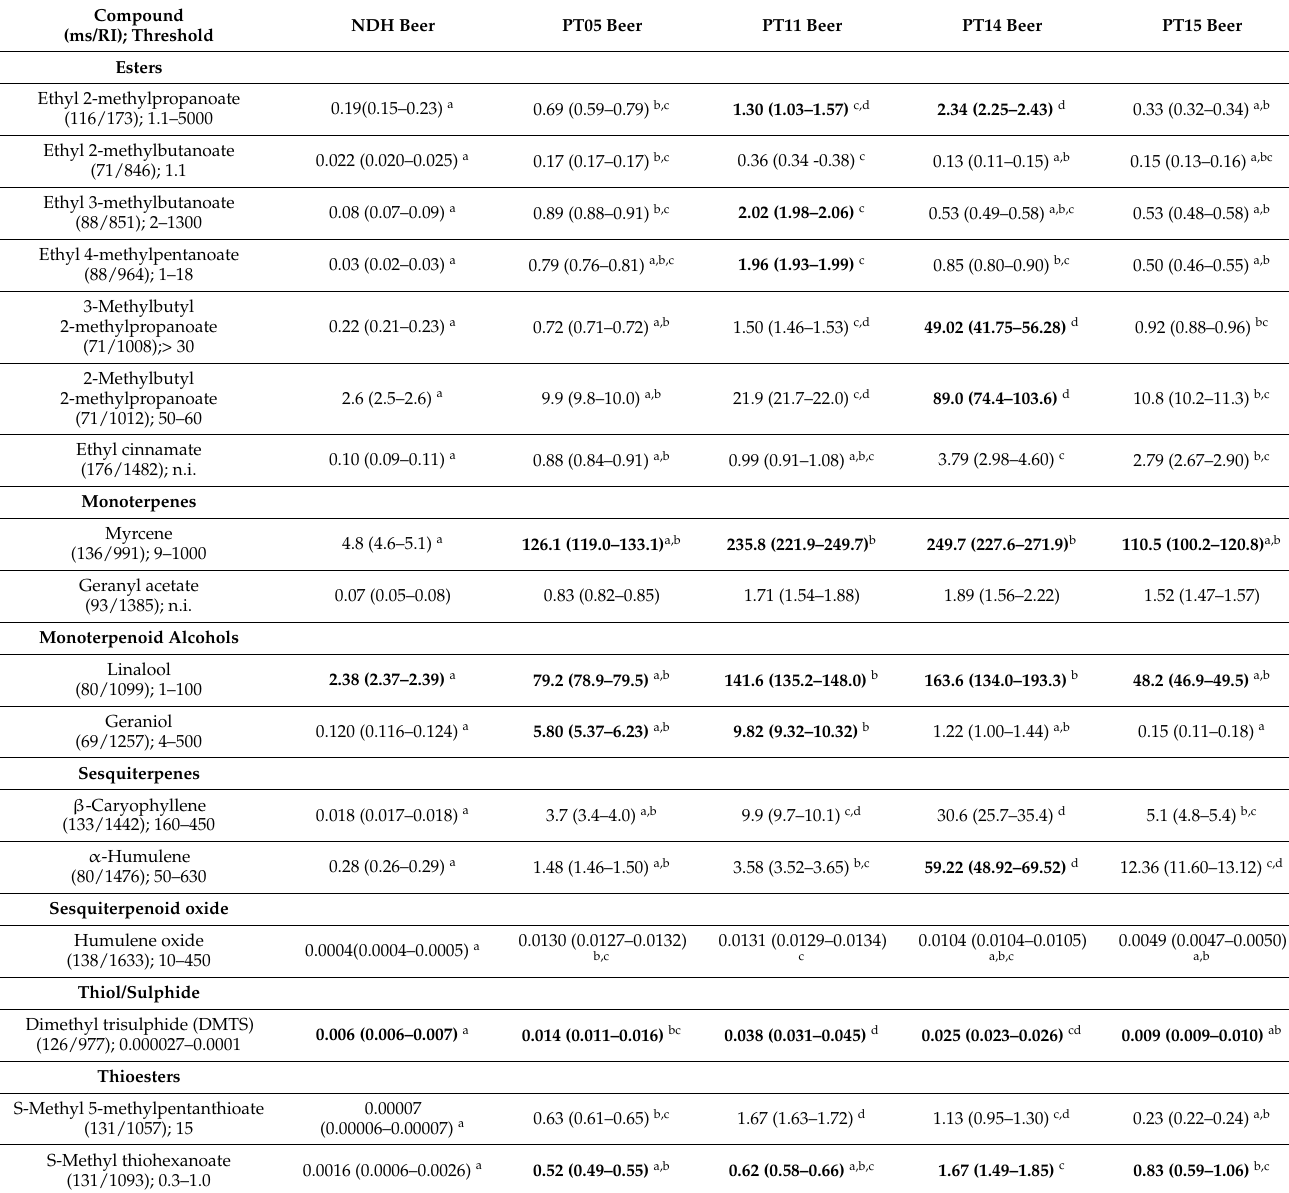
Table 3. Concentrations and thresholds ( µ g/L) of volatile compounds in beers dry-hopped with Portuguese wild